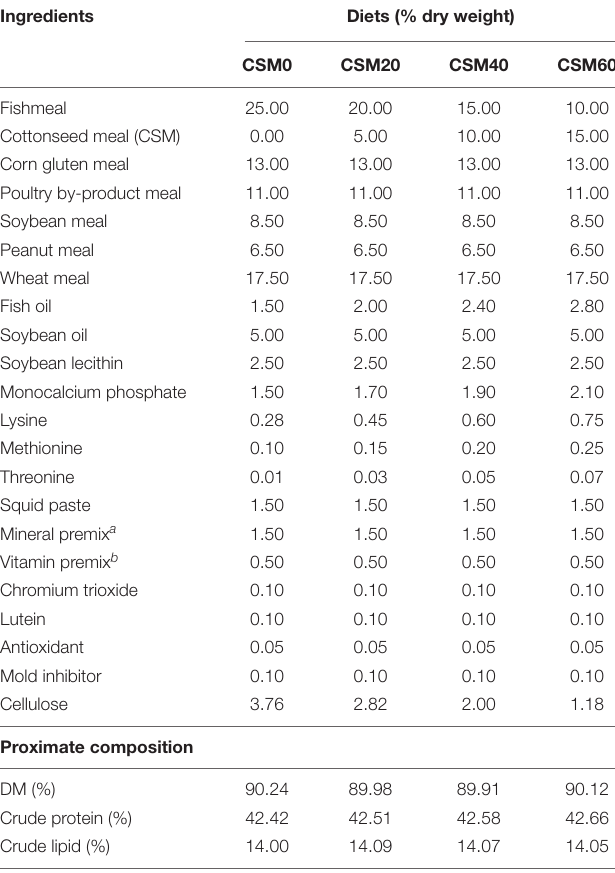
TABLE 1 | Experimental diets formulations.